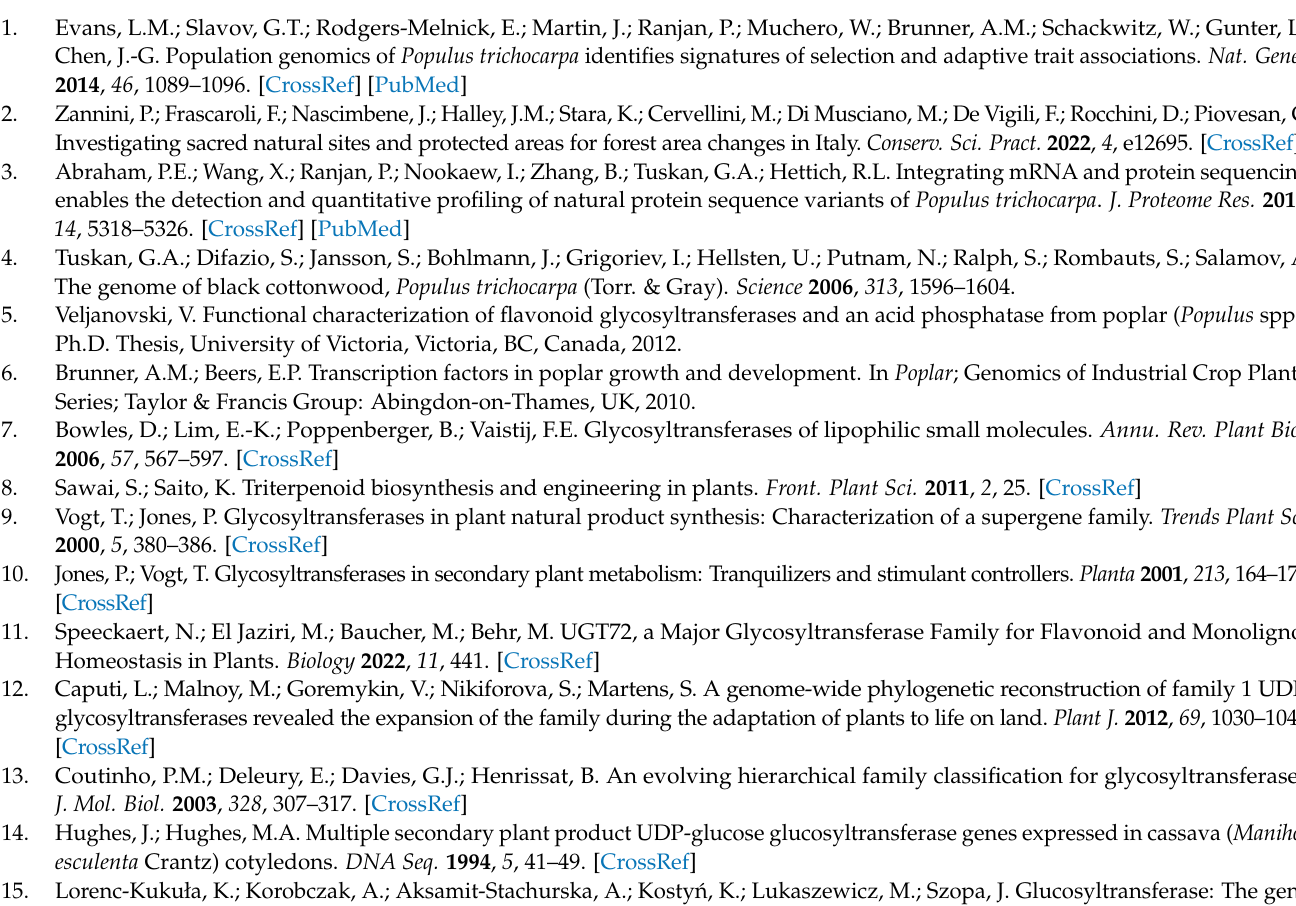
Figure S3: Gene structure comparison among eight eudicots; Figure S4: Heat map of 168 UGTs expressed in various tissues of Populus ; Figure S5: Co-expression networking of UGT genes in Populus ; Table S1: Identified UGTs in Populus and their genomic information alongside PSPG motif sequences; Table S2: Gene duplication estimation of UGTs in Populus using Ka/Ks calculations; Table S3: Gene structure analysis in Populus UGTs; Table S4 Expression analysis of UGTs in Populus